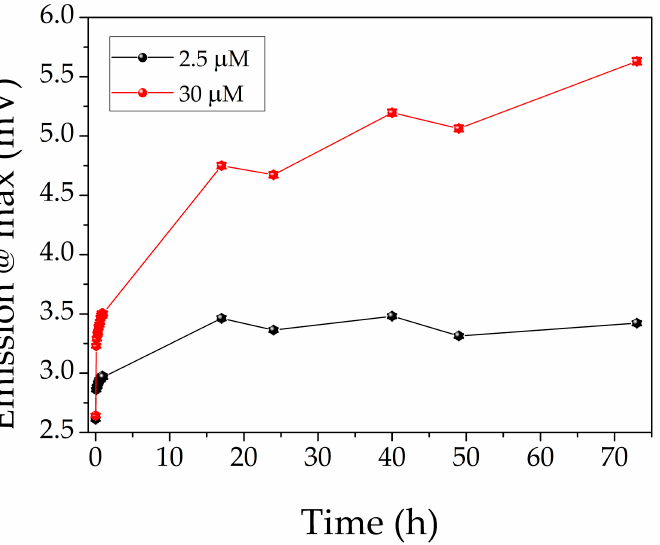
Figure 3. Time dependence of AgNCs solution polluted with Pb(II) at 2.5 µM (black points) and 30 µM (red points).